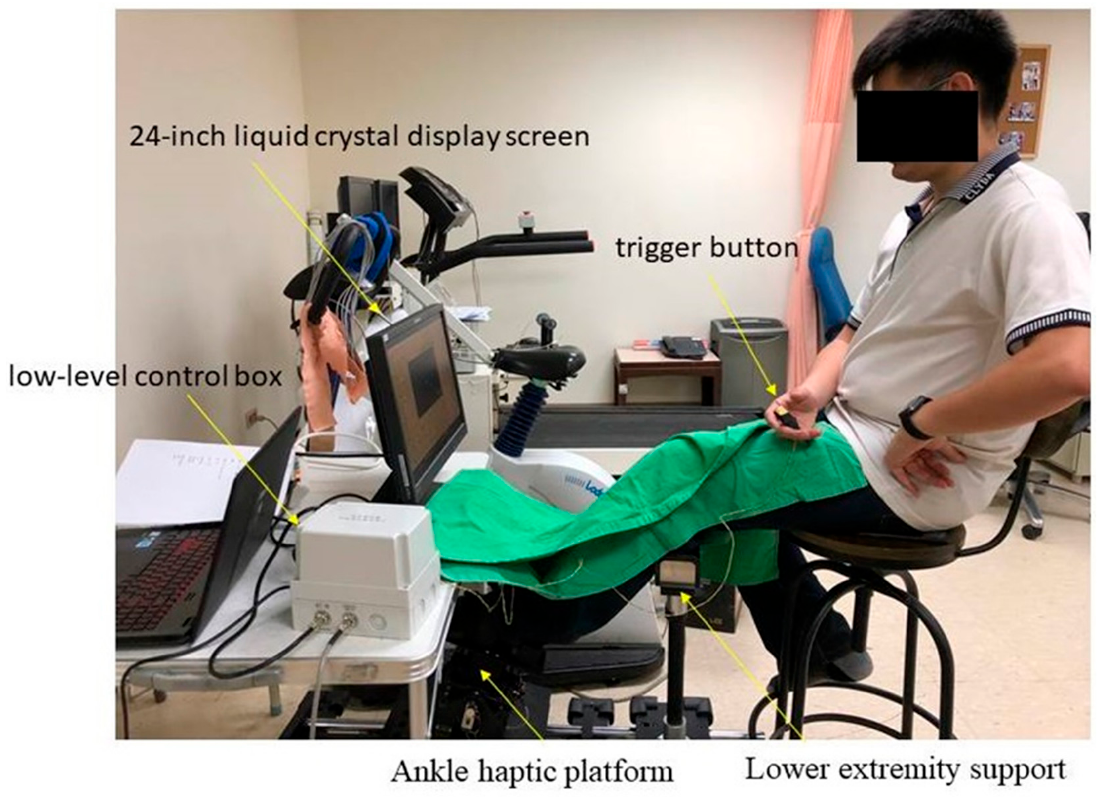
Figure 3. Experimental setting.